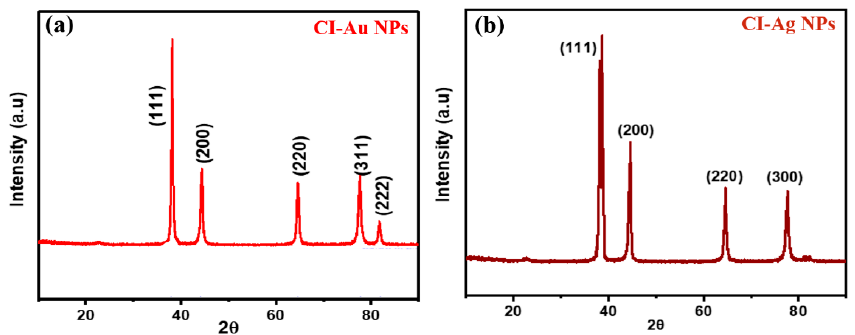
Figure 2. XRD patterns of green synthesized ( a ) CI-Au NPs and ( b ) CI-Ag NPs using leaves extract of C. inerme .